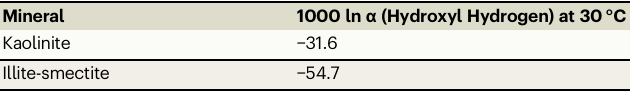
Table 2 | The hydroxyl hydrogen fractionation factors used in this study for kaolinite 39 , and for illite-smectite 40 Mineral 1000 ln α (Hydroxyl Hydrogen) at 30°C Kaolinite − 31.6 Illite-smectite − 54.7